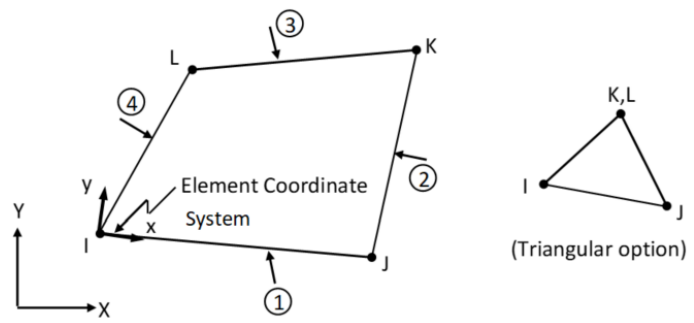
Figure 6. PLANE42 geometry.